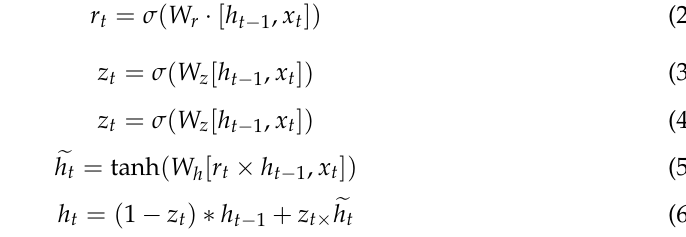
indicates the status information